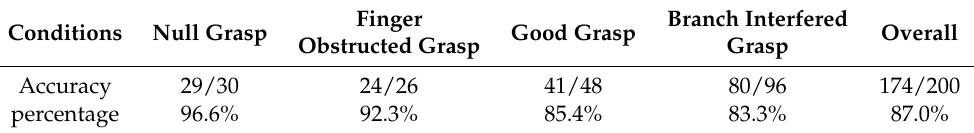
Table 1. Grasp status detection experiment